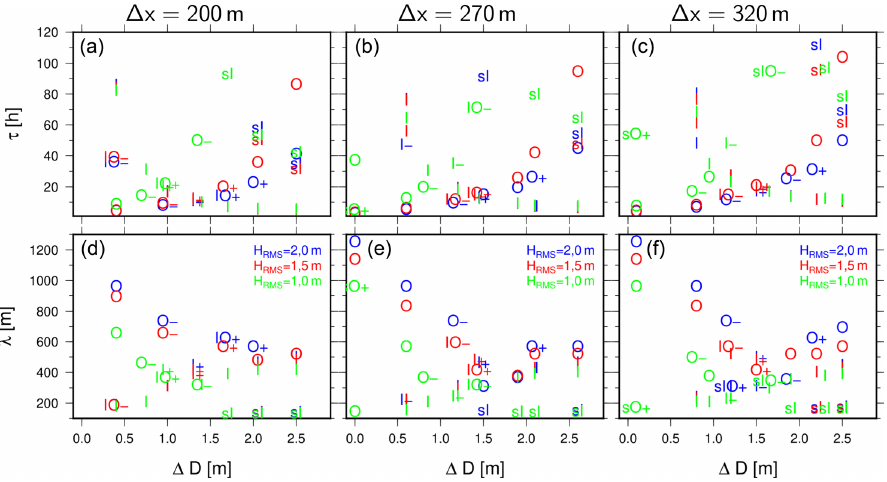
Figure 8. Growth time (a–c) and rip channel spacing (d–f) as a function of (cid:49)D . The left (a, d) , centre (b, e) and right (c, f) panels represent results obtained for (cid:49)x = 200, 270 and 320m, respectively. Blue, red and green symbols refer to wave height equal to 1.0, 1.5 and